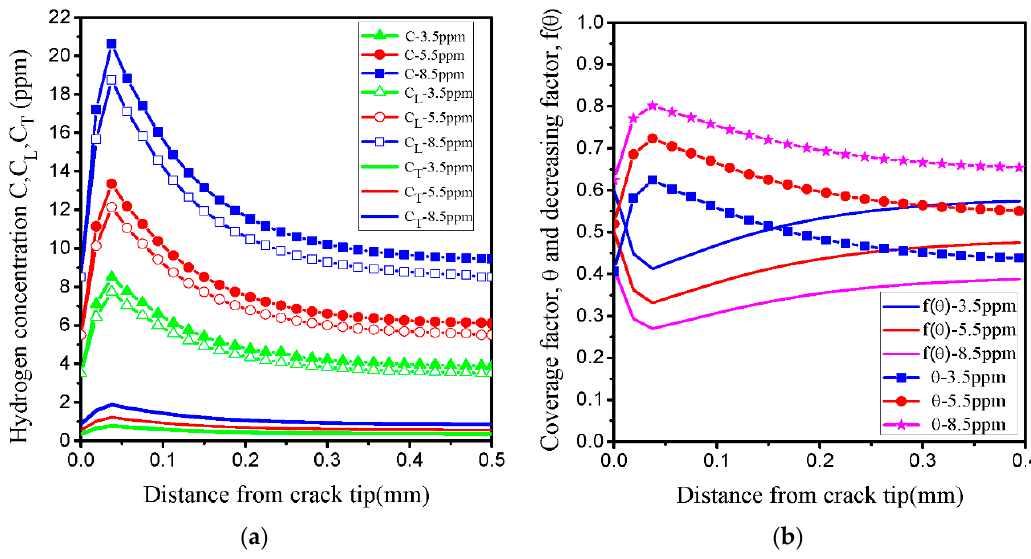
Figure 14. ( a ) Calculation of the hydrogen concentration ( C L , C T , C = C L + C T ) as a function of distance from the crack tip for C L 0 (3.5, 5.5, 8.5 ppm); ( b ) hydrogen coverage factor θ and hydrogen decreasing factor f ( θ ) as a function of distance from the crack tip for C L 0 (3.5, 5.5, 8.5